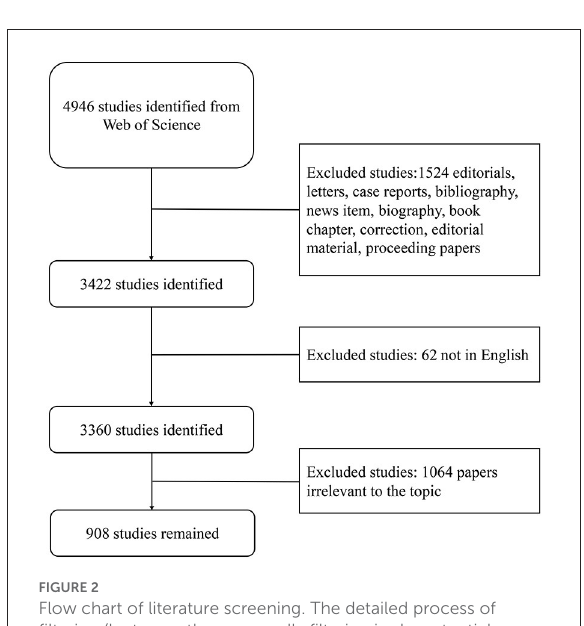
FIGURE2 Flow chart of literature screening. The detailed process of filtering (by two authors manually filtering irrelevant articles through abstract and full text, excluding irrelevant